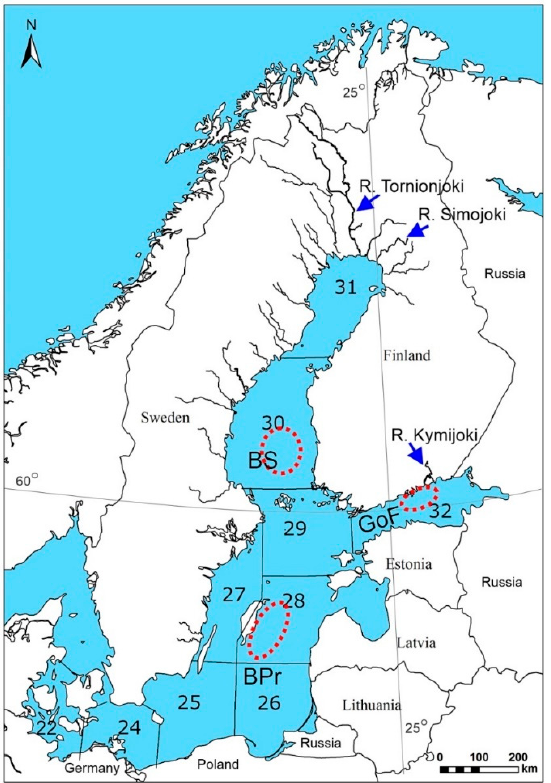
Figure 1. The three areas of the Baltic Sea where salmon ( Salmo salar ) were caught are depicted by broken-lined ellipses. The International Council for the Exploration of the Sea (ICES, origin of the map) subdivisions (SD) are presented: BPr = Baltic Proper (SDs 25–29), BS = Bothnian Sea (SD 30), and GoF = Gulf of Finland (SD 32). The Gulf of Bothnia consists of SDs 30 and 31. The Rivers Tornionjoki, Simojoki, and Kymijoki are indicated (blue arrows). The latitude of 60° and longitude of 25° are indicated.